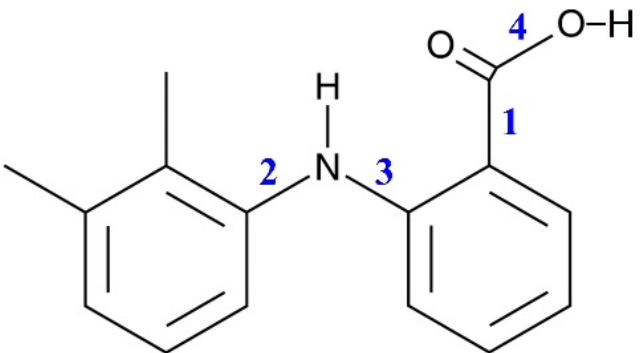
Figure 1. Schematic representation of the MA molecule structure. The numbers indicate the bonds around which the fragments can rotate, leading to the formation of various conformers.